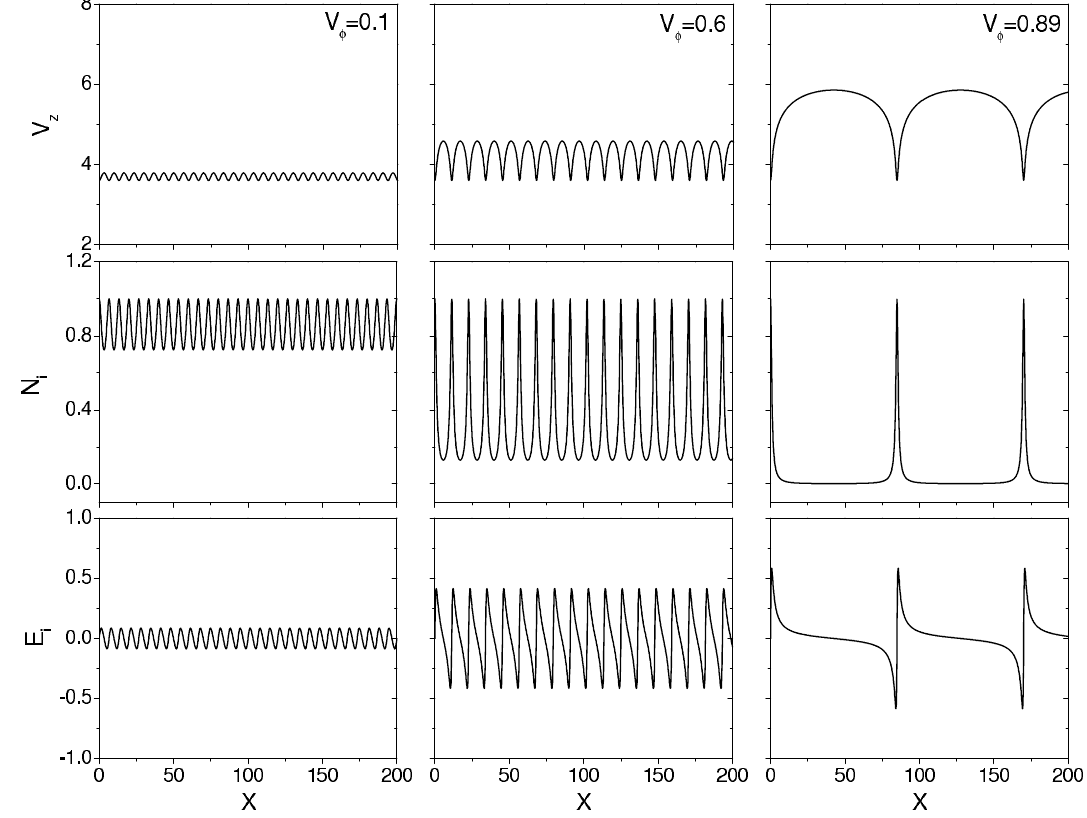
Fig. 1. Features of the forward-propagating branch of solitary waves via the axial speed V z (top-row panels), ion density N i (middle-row panels), and wave-field strength E i (bottom-row panels): (1) solitons with a sinusoidal shape in E i excited by a slow-speed azimuthal flow of V φ 0 = 0 . 1 (left-column panels); (2) solitons with a sawtooth shape in E i excited by a medium-speed azimuthal flow of V φ 0 = 0 . 6 (middle- column panels); (3) solitons with a bipolar shape in E i excited by a fast-speed azimuthal flow of V φ 0 = 0 . 89 (right-column panels). Input parameters: ζ = 1 . 2, M = 1 . 8, and R = 0 . 9; Boundary conditions: { V r ,9 }={ 0 , 0 }